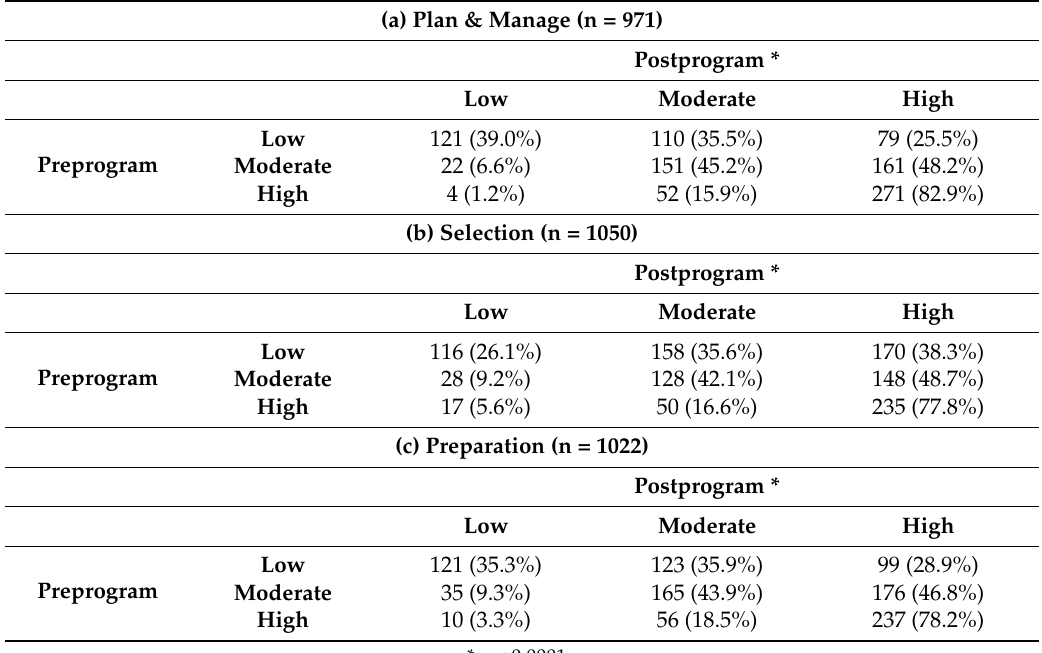
Table 5. The number of participants in low, moderate and high scoring groups for the three food literacy behaviour factors (a) plan & manage, (b) selection and (c) preparation. Percentages refer to the percentage of the specific preprogram population (low, moderate or